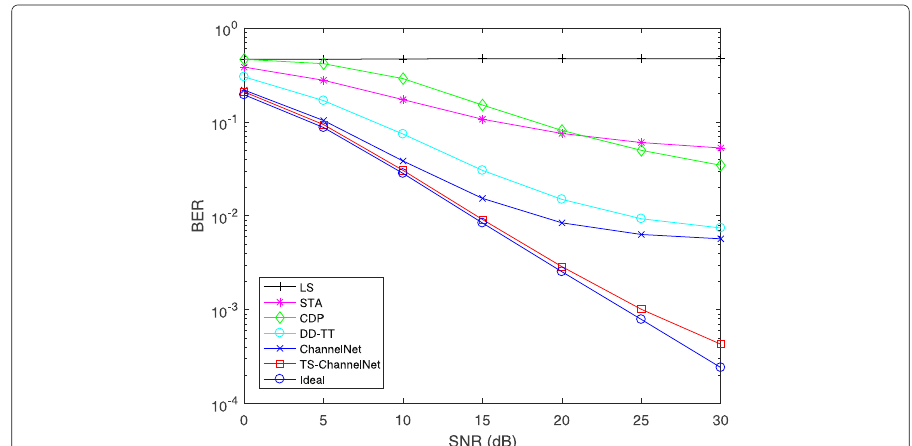
Fig. 5 BER with 4QAM modulation, maximum Doppler = 500 Hz, and 60 OFDM symbols (VTV Urban Canyon)